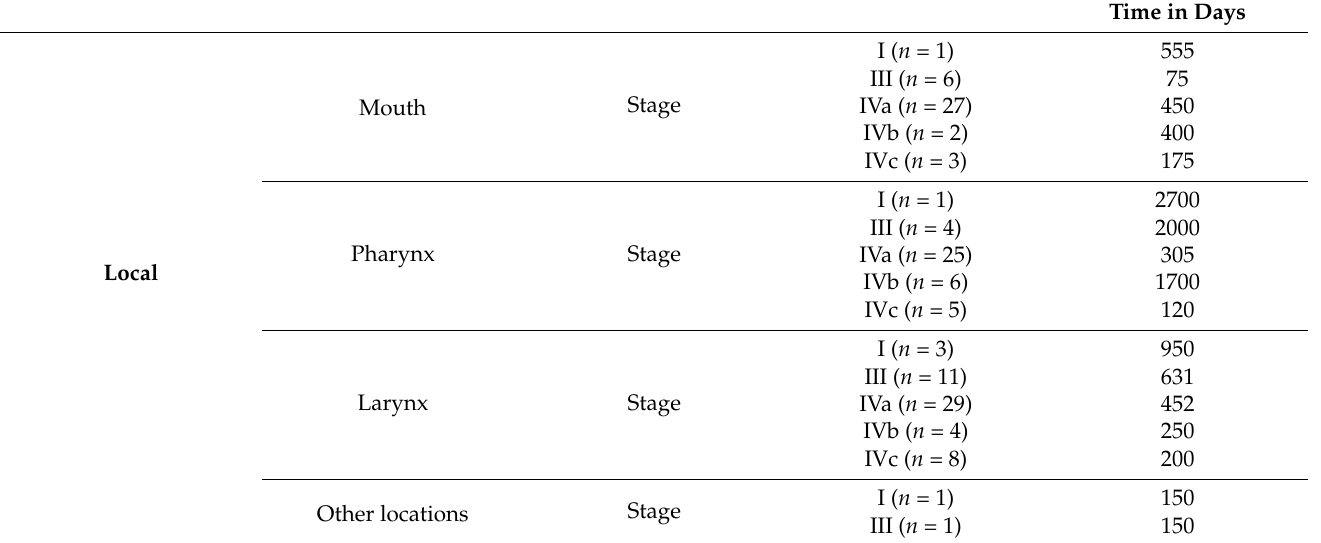
Table 5. Median survival time by cancer location and stage.